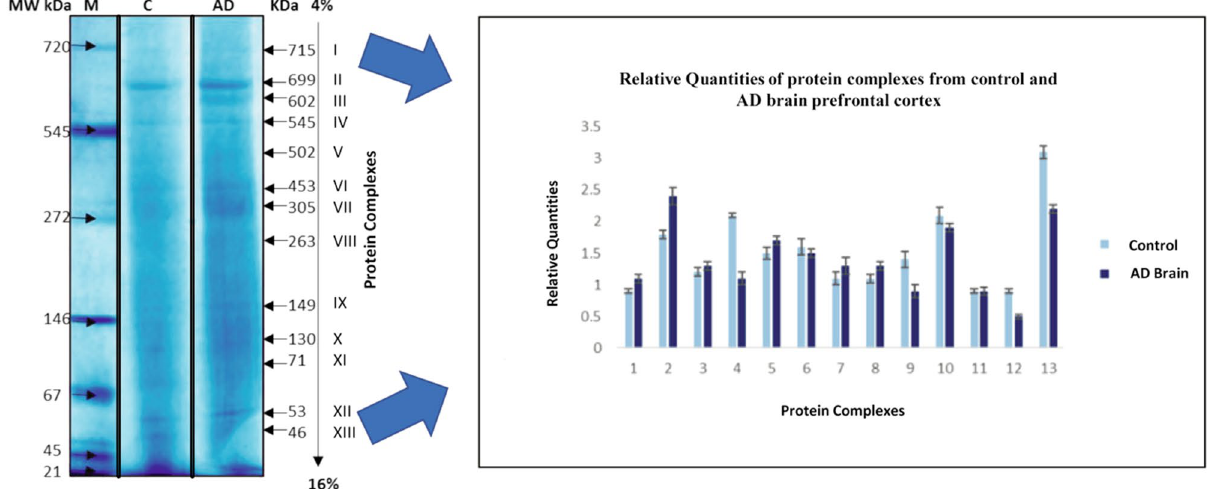
Figure 1. Pattern of protein complexes (120 µg) obtained from the separation of control and AD sample (lane 2 and 3) resolved on 1D BN-PAGE 4–16% gel. Complex IV and XIII represent significant expression alterations among ageing control and AD brain samples. M: Molecular weight marker; C: Healthy control subjects; AD: Alzheimer’s disease